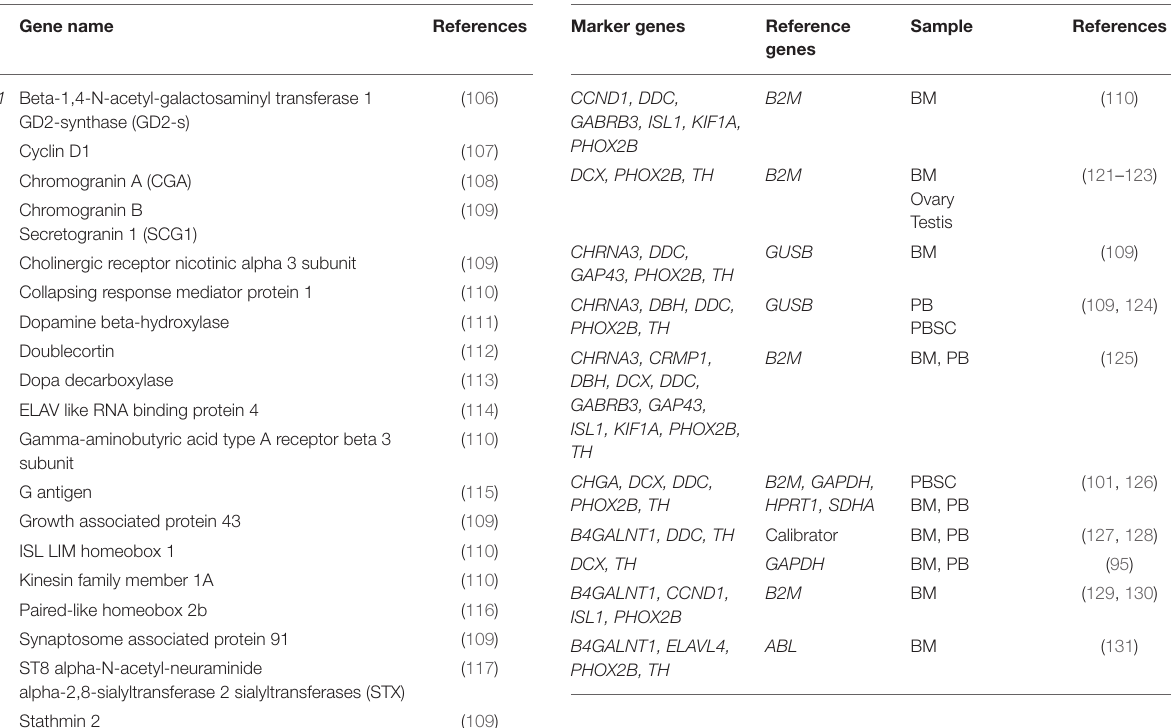
TABLE 2 | Neuroblastoma-associated mRNAs. TABLE 3 | Sets of neuroblastoma-associated